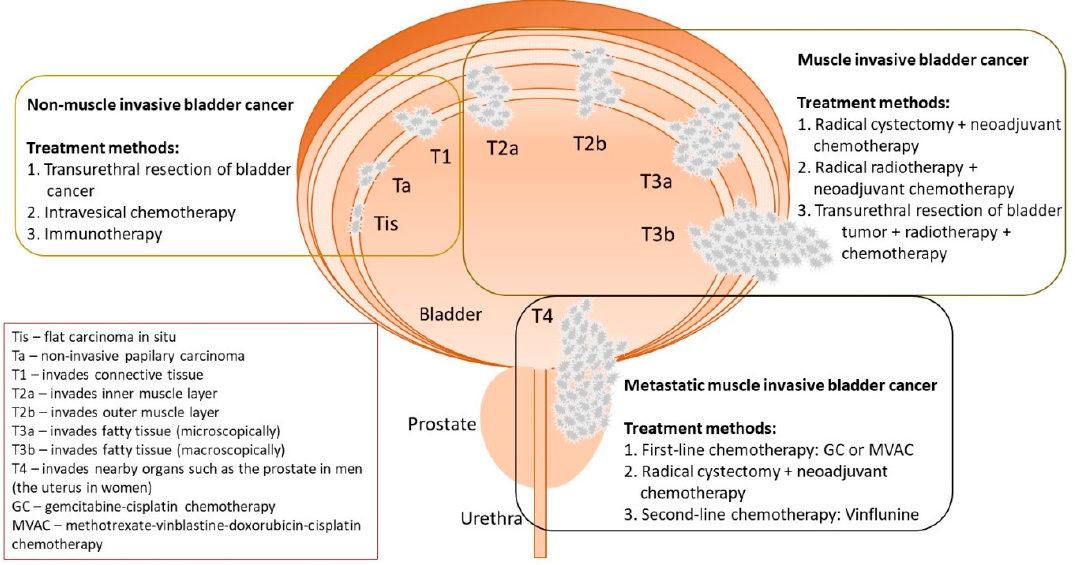
Figure 1. Stages of bladder cancer and methods of its treatment (based on Sanli et al. [13]).